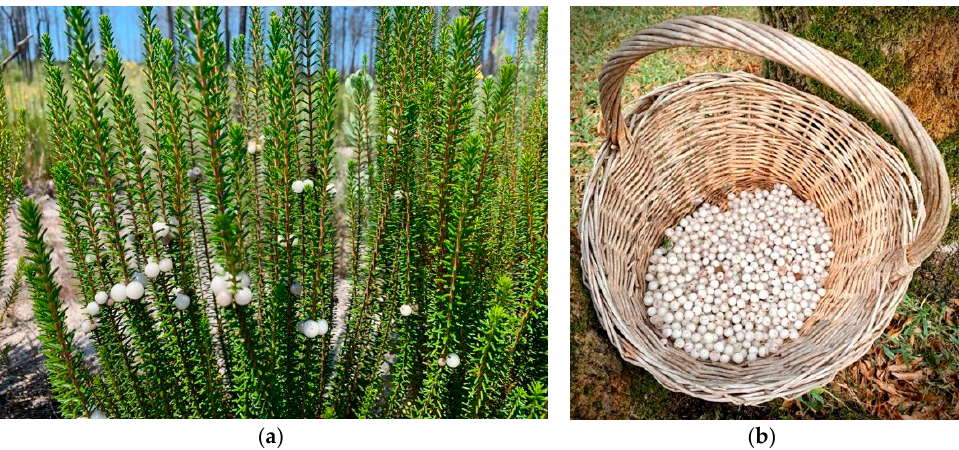
Figure 1. Endemic shrub of Atlantic coastal dunes of Iberian Peninsula: ( a ) Corema album (L.) D. Don (Ericaceae) shrub and ( b ) its small fruits (Portuguese white crowberries) in a traditional basket.